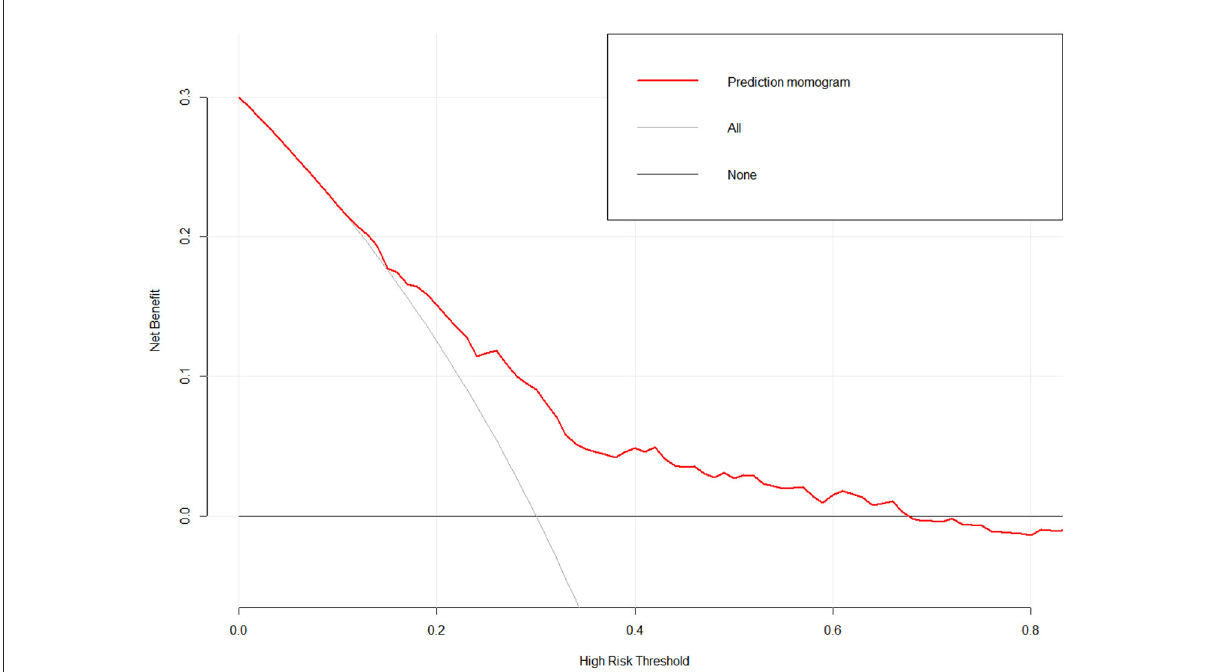
FIGURE4 Decision curves of the nomogram. The y-axis measures the net benefit. The red line represents the HIV incidence risk nomogram. The light black solid line represents the assumption that all patients are diagnosed as DN. Deep black solid line represents the assumption that no patients are diagnosed as